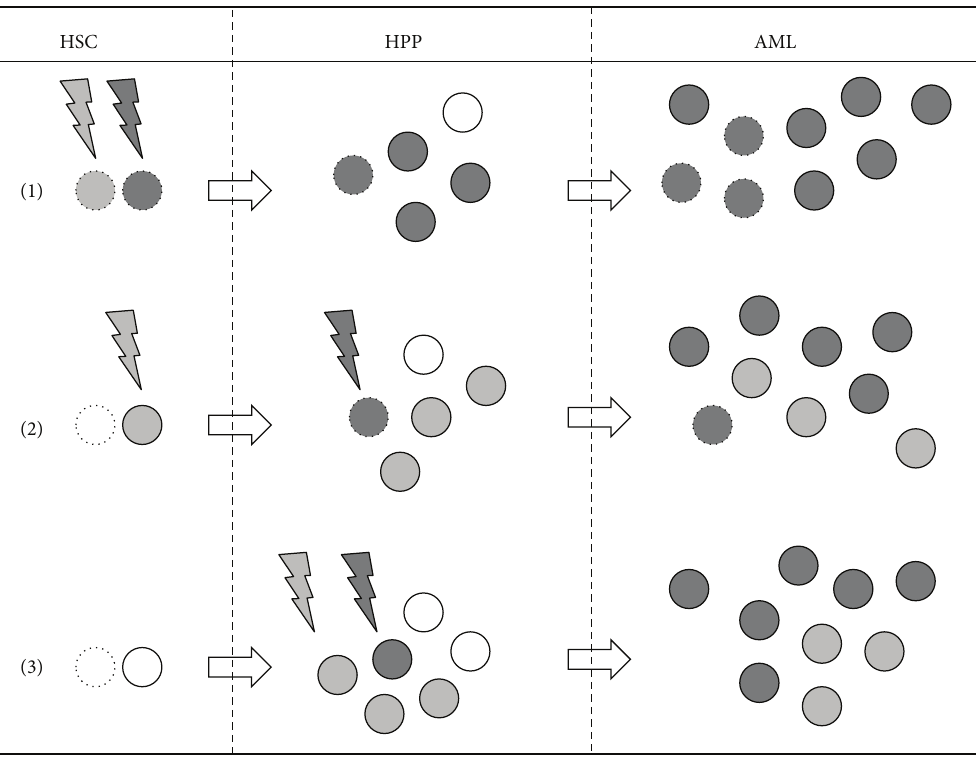
Figure 2: Proposed model for leukemogenesis. According to this model, AML arises following (at least) three different scenarios. In the first one (1) both “class-2” (represented as “light grey lightning bolts”) and “class-1” (“dark grey lightning bolts”) mutagenic events happen in the HSC (“white dotted circles”), thus creating a rapidly expanding clone endowed by some of the persisting physiological abilities of HSC, such as self-renewal ability (all cells with self-renewal abilities are represented as “dotted circles” in the figure). The resulting leukemia therefore contains more L-IC (represented by “grey dotted circles”), with consequences on the resistance to chemotherapy and the chance of relapse. In the second scenario (2) an initial “class-2” event gives rise to a preleukemic phase where different subclones (“light grey circles”) compete one another and with residual hematopoiesis (“white circles”) until the emergence of a dominant clone which benefits from self-renewal ability (“dark grey dotted circles”), conferred by an additional “class-1” mutation. This is the scenario thought to model leukemogenesis in the case of CBF AML. In the last scenario (3) leukemia arises from “class-2” and “class-1” events both happening in early committed HPP; leukemia therefore consists mainly of dysplastic HPP which are possibly more sensitive to chemotherapy and agents forcing